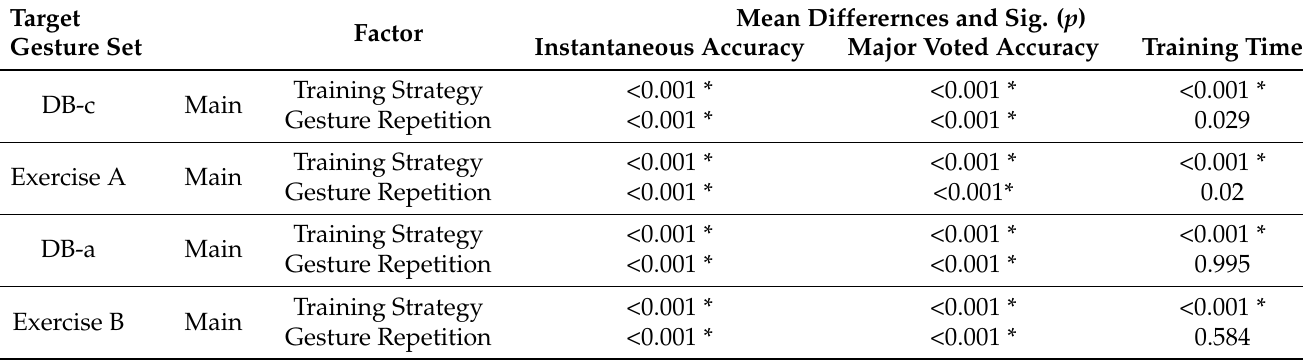
Figure 6. The comparison of the accuracy of instantaneous recognition and major voted recognition of the target network under the TL strategy and non-TL strategy for new subject recognition: ( a ) DB-c and ( b ) Exercise A. Table 1. Two-way ANOVA analysis results for the target network. * means the significant difference of p <